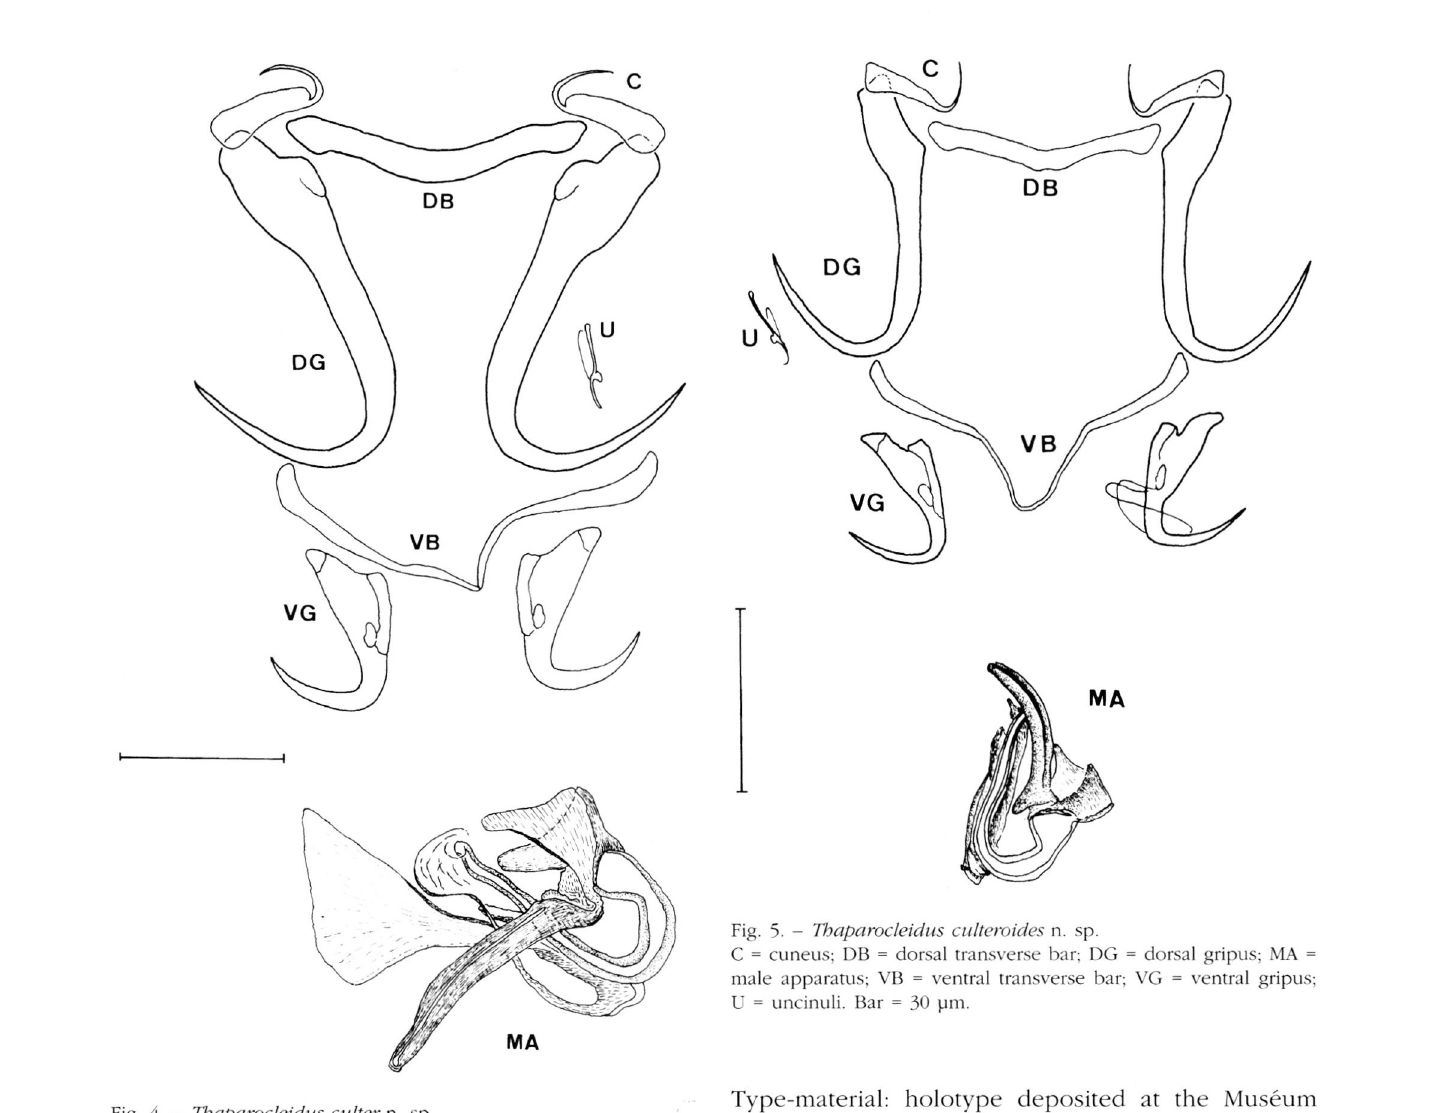
Fig. 4. - Thaparocleidus culter n. sp. C = cuneus; DB = dorsal transverse bar; DG = dorsal gripus; MA = male apparatus; VB = ventral transverse bar; VG = ventral gripus; U = uncinuli. Bar = 30 um.